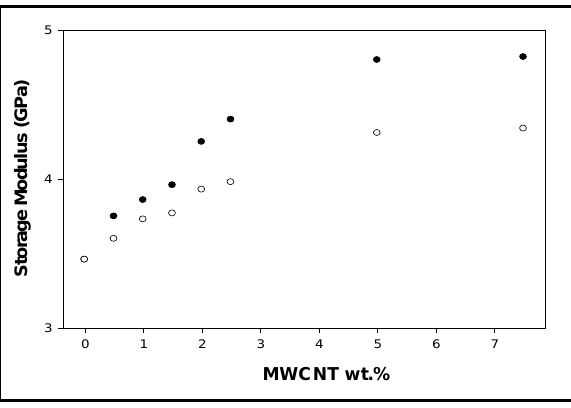
Figure 8. Storage modulus variation with CNT loading in Ar-CNT-P ( ○ ) and Ar-CNT-C (●) composites.